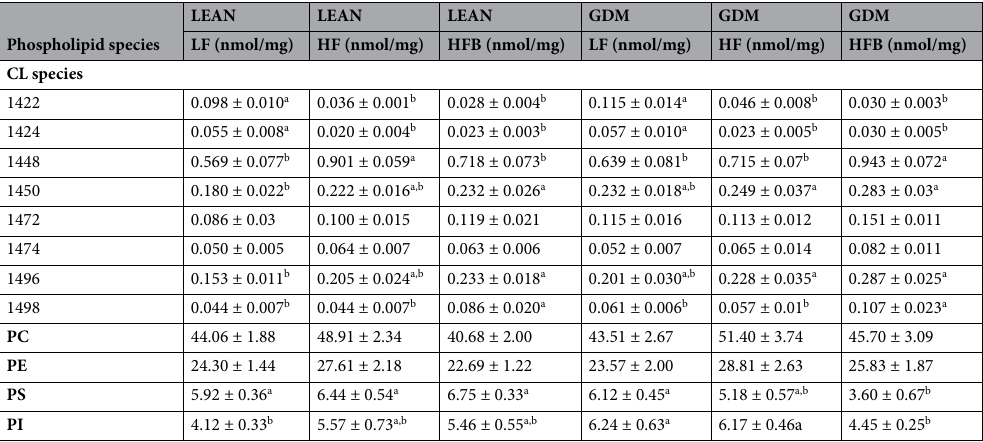
LEAN LEAN LEAN Phospholipid species